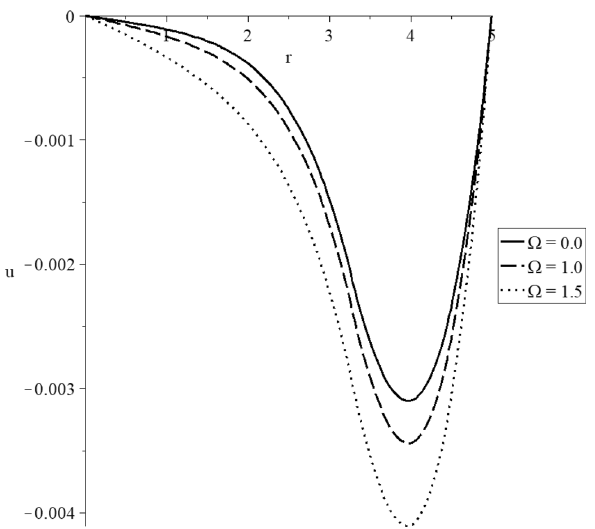
Figure 18. The displacement distribution with various values of the angular velocity of the rotation